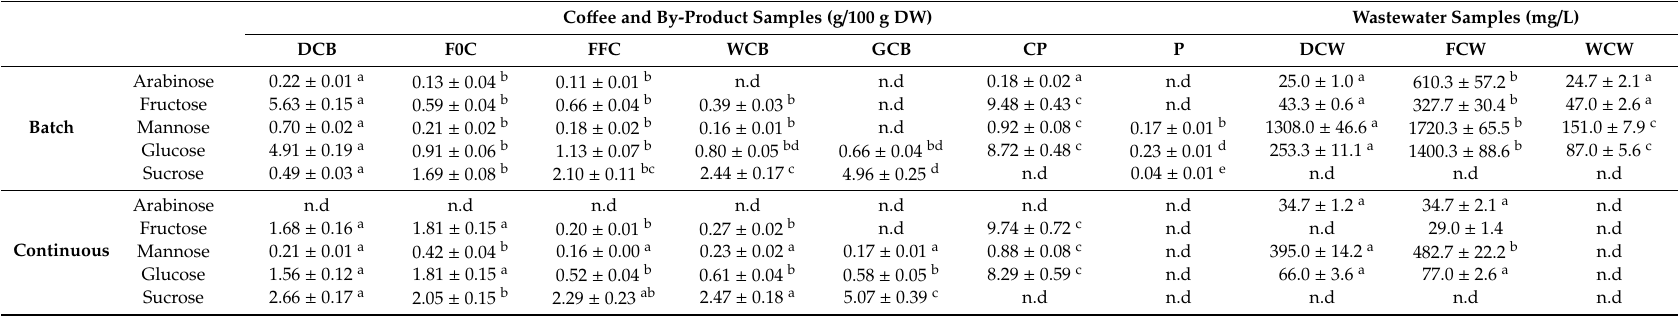
Table 2. Composition of reducing sugars in co ff ee beans, co ff ee by-products and wastewater during the batch and continuous processing. Co ff ee and By-Product Samples (g / 100 g DW) Wastewater Samples (mg /